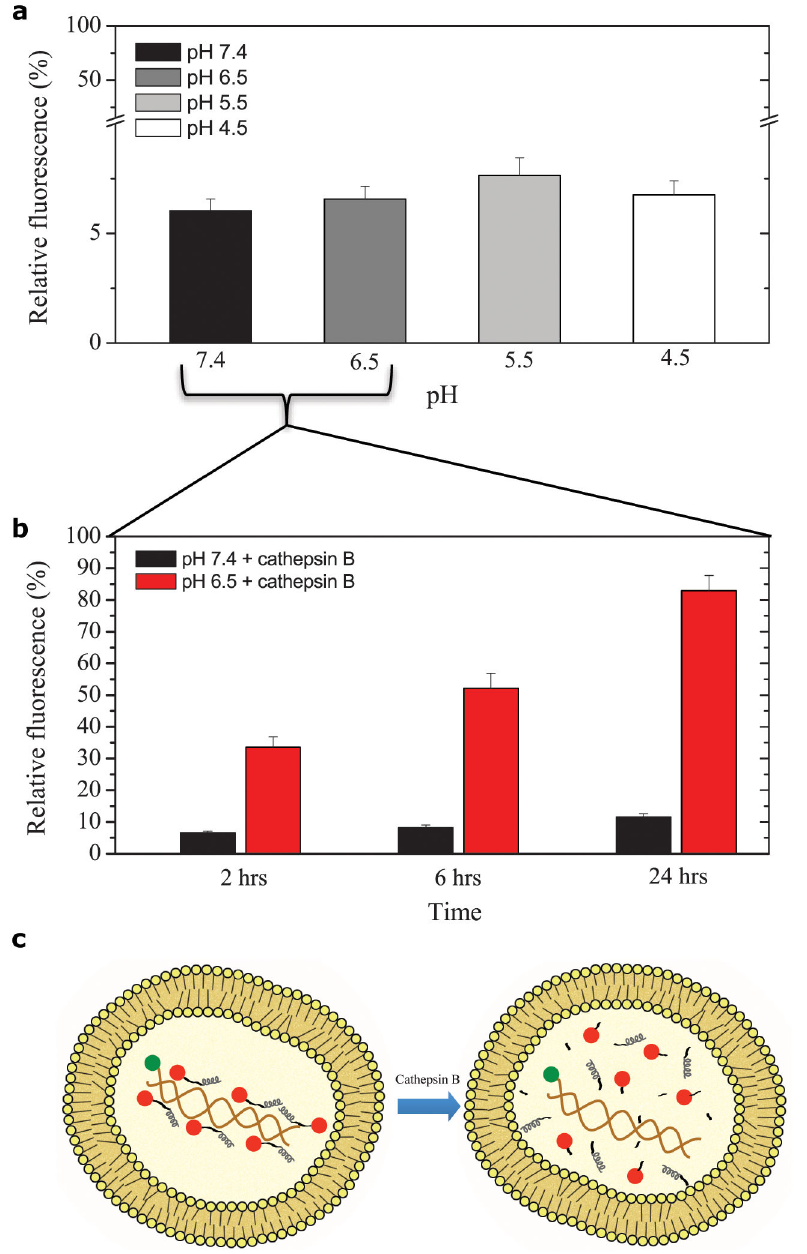
Figure 5. In vitro peptide/DNA complex stability evaluation in endosomal-like conditions. ( a ) EtBr exclusion assay performed as explained in caption 1b in PBS buffer at different pH: 7.4 (black column), 6.5 (dark grey), 5.5 (light grey), 4.5 (white). Y-axis break from 10% to 15% at 70% of the axis length. ( b ) EtBr exclusion assay 24 hours time-lapse performed at 37°C incubating CM -Tat /plasmid DNA binary complexes at pH=7.4 (black column) or pH=6.5 (red) with cathepsin B enzyme. ( c ) 18 11 Graphical scheme of CM -Tat /plasmid DNA binary complexes disassembling evolution inside endosomal vesicle. 18 11